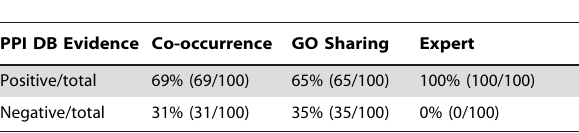
Table 4. Specificity Evaluation.